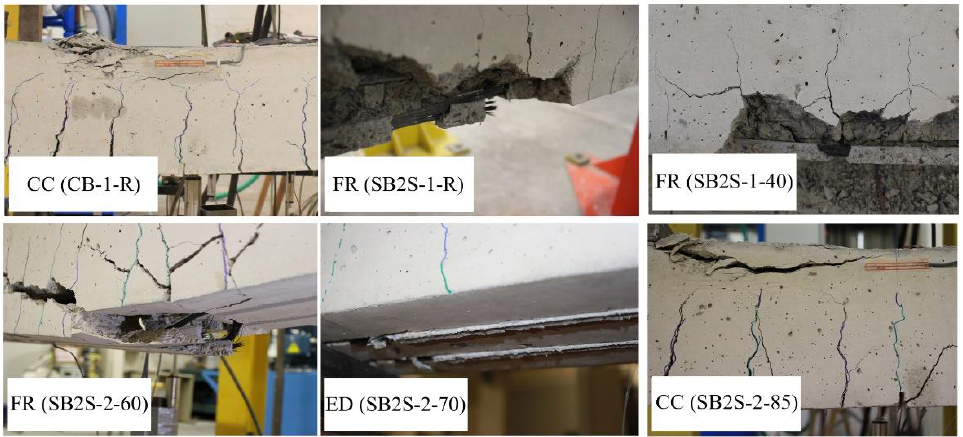
Figure 12. Experimental failure modes.